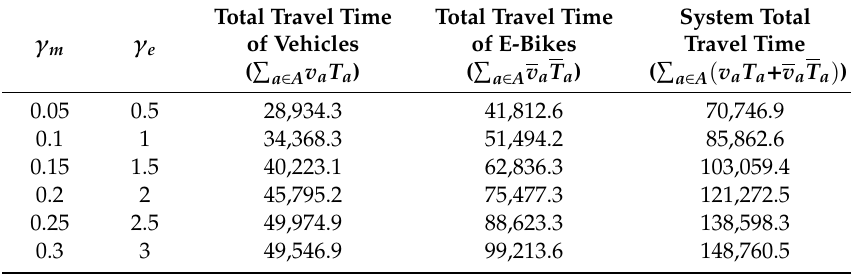
Figure 3. Sensitivity analysis regarding parameters related to out-of-pocket cost. Table 5. Sensitivity analysis regarding parameters related to interactions between vehicles and